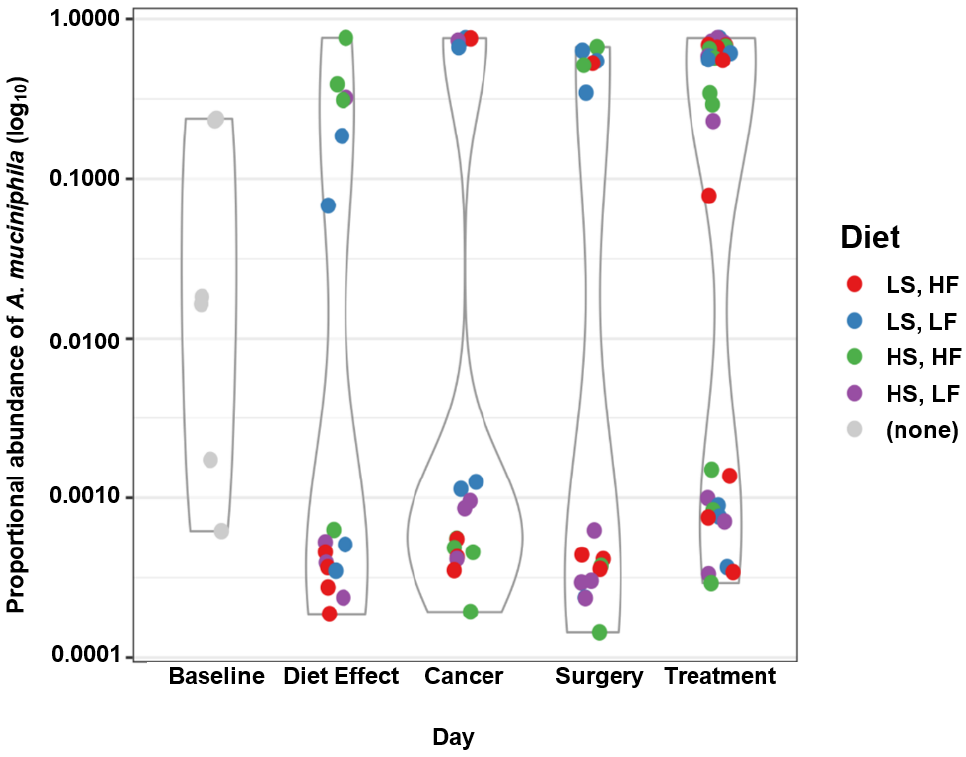
Figure 4. Abundance of Akkermansia muciniphila changes over time.